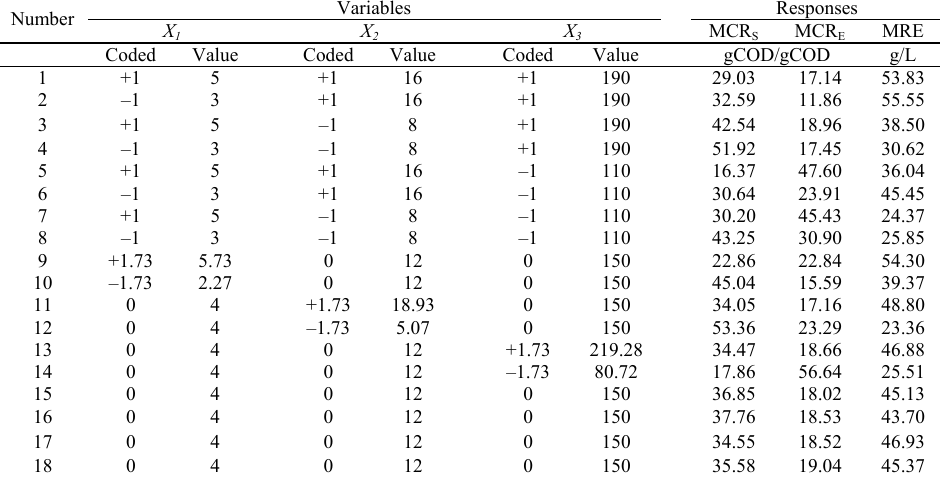
Table 3: The results of responses and design values.